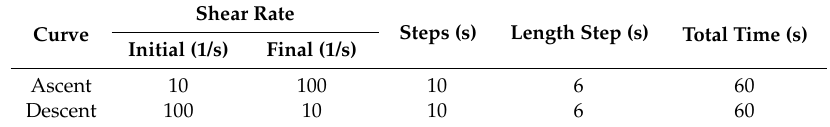
Table 4. Input parameters used to construct the shear gradient and viscosity ascent and descent curves.